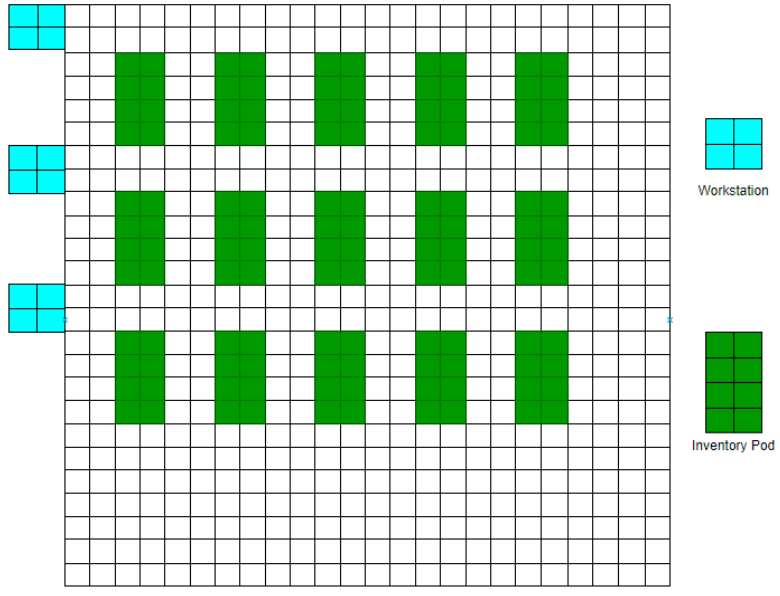
Figure 1. Sample Layout of Warehouse Environment.